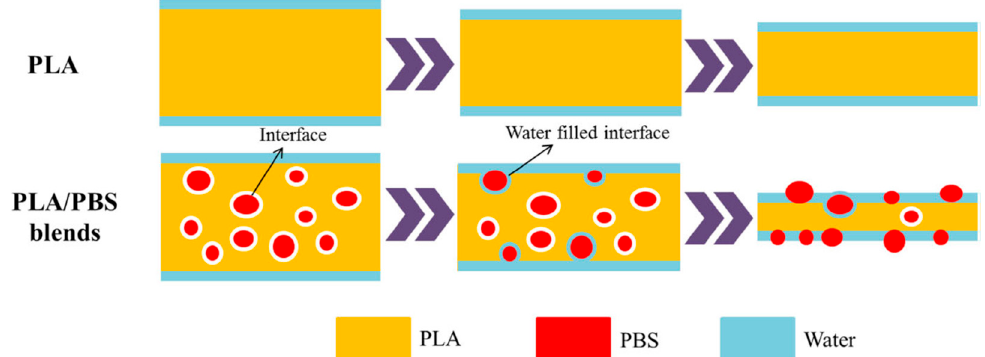
Figure 7. Schematic representations for the hydrolytic degradation process of pure PLA and PLA/PBS blends [35]. Reprinted by permission from Springer Nature: Polymer Bulletin, Accelerated hydrolytic degradation of poly(lactic acid) achieved by adding poly(butylene succinate), Wang, Y.-P.; Xiao, Y.-J.;